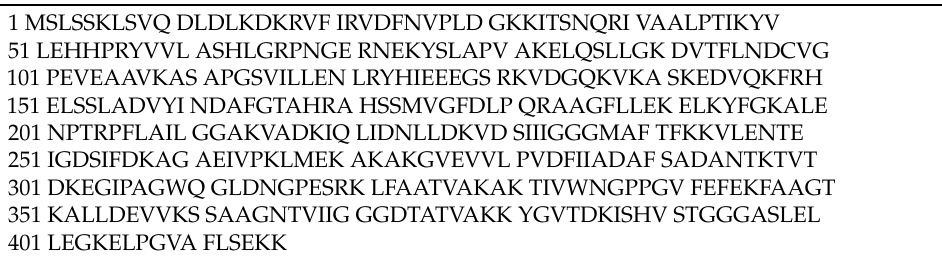
Table 3. The amino acid sequence of 54 kDa protein from S. pastorianus